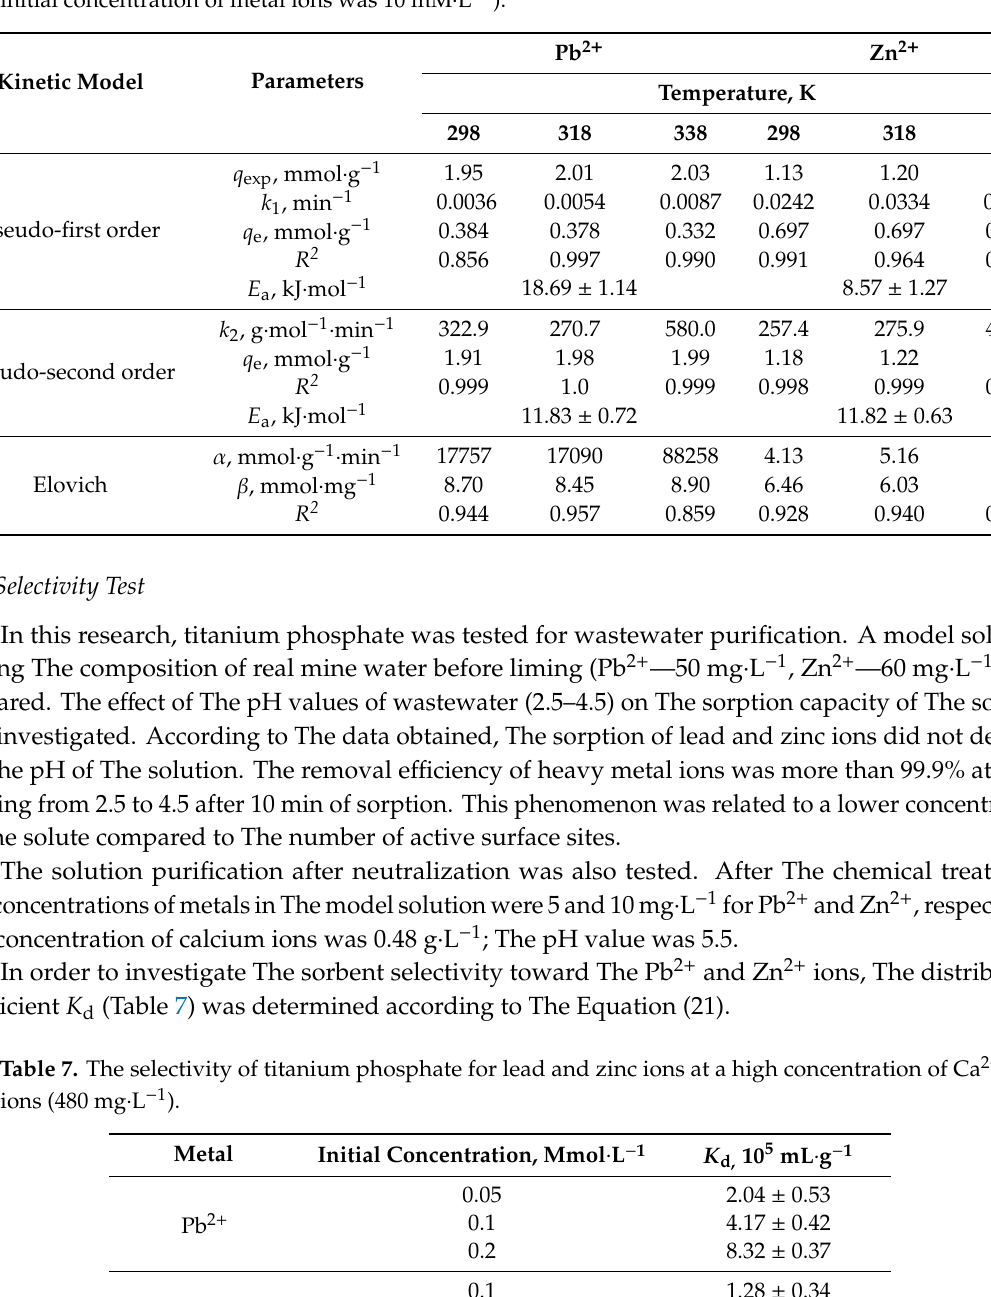
Table 6. Kinetic parameters of The models for lead and zinc ion adsorption on titanium phosphate (the initial concentration of metal ions was 10 mM · L − 1 ).